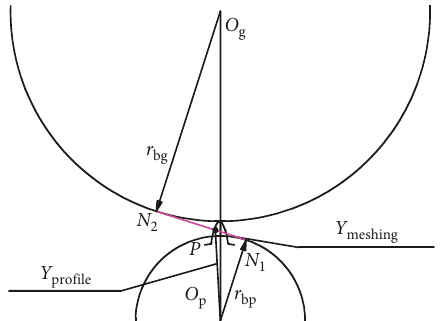
Figure 4: Relationship between tooth depth and length of meshing